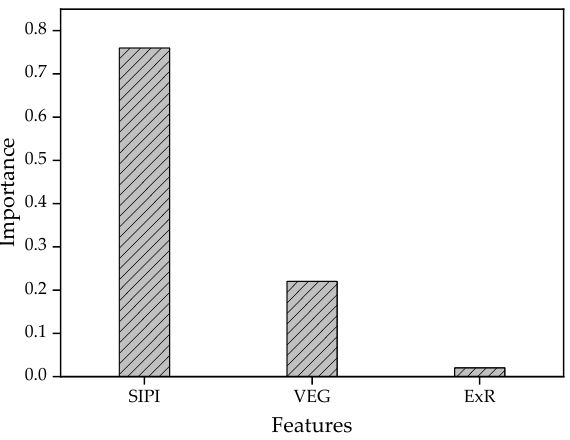
Figure 4. Feature importance assessment based on random forest model. Zhao et al. [7] developed two estimation models for Fv/Fm of potato leaves with test set R 2 of 0.807 and 0.822 and RMSE of 0.018 and 0.017, respectively. Yi et al. [8] developed a generalized estimation model of Fv/Fm for poplar leaves and cherry leaves with R 2 = 0.88. In a study [9] estimating Fv/Fm in winter wheat, training set R 2 = 0.50, RMSE = 0.012, test set R 2 = 0.55, RMSE = 0.014. In these previous estimation studies of Fv/Fm based on hyperspectral, the highest R 2 was of 0.88, and the highest accuracy combined model with- out hyperparameter optimization in this study had R 2 of 0.868, which shows that the esti- mation accuracy of multispectral and RGB is not as good as hyperspectral. However, Yang